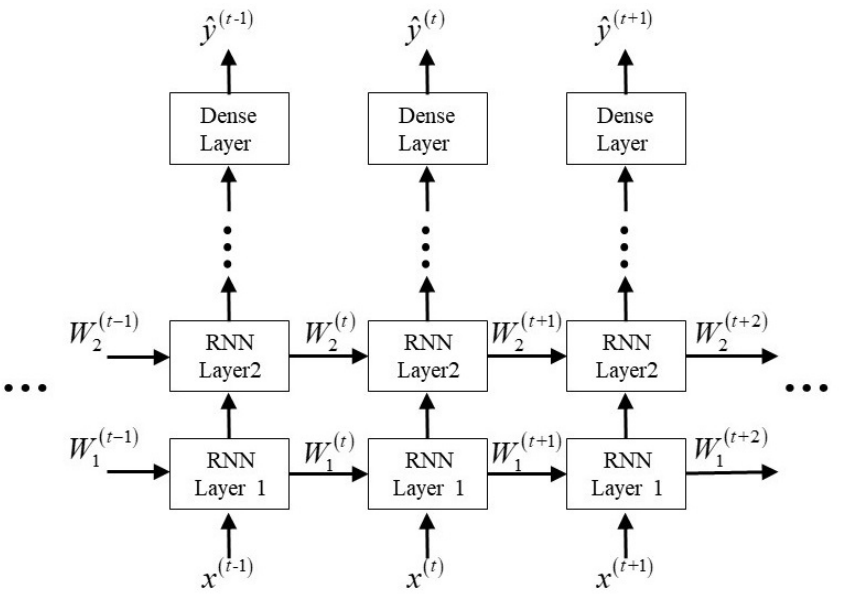
Figure 6. Construction of the recurrent neural network